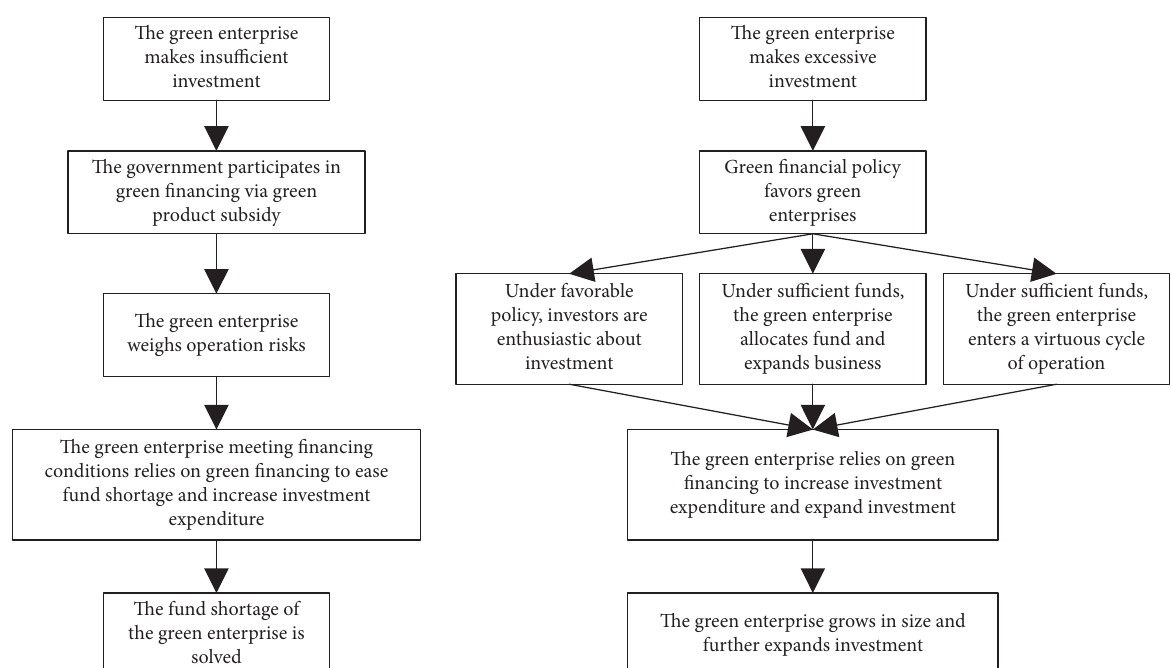
Figure 3: Association mechanism between green financing and green corporate investment